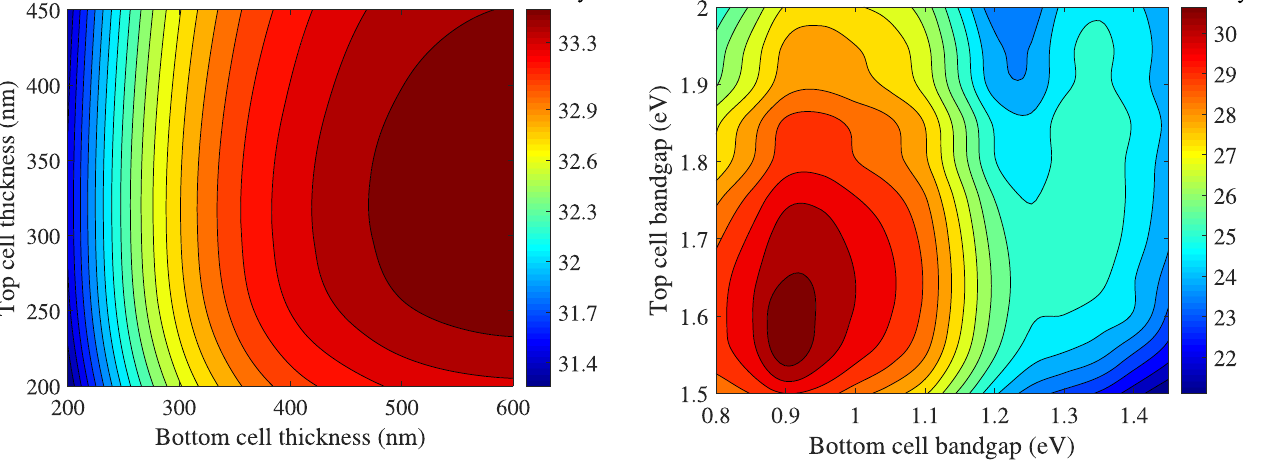
Fig. 10. 4T tandem solar cell ef fi ciency for different bandgaps of top and bottom cells with trap-assisted recombinations. The thicknesses for both the top and bottom cells are fi xed at 350 nm. Both bulk and interface traps are considered in top and bottom